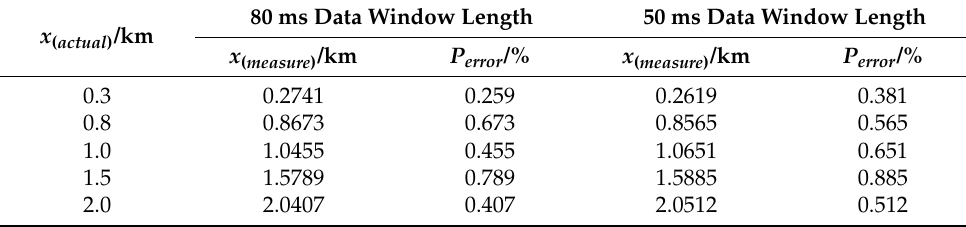
Table A3. Fault location results and errors with data window